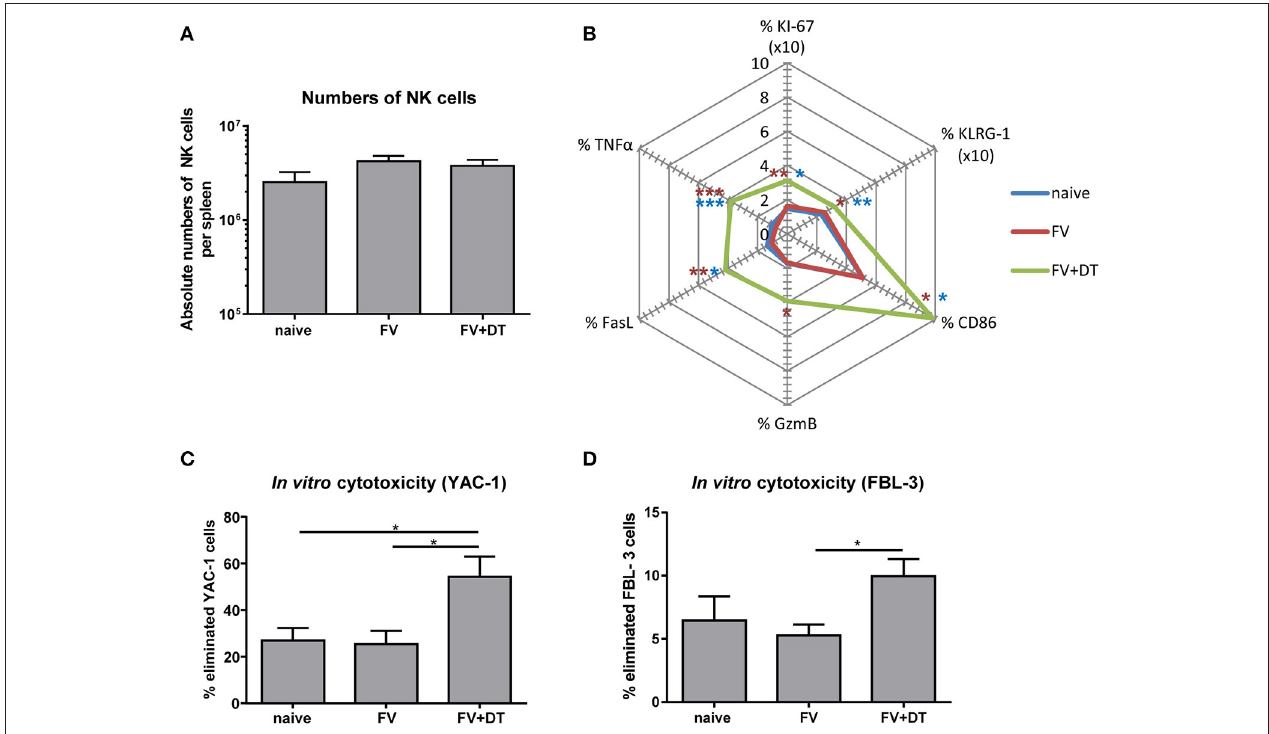
FIGURE 1 | Influence of Tregs on the NK cell phenotype during an acute FV infection. C57BL/6 and DEREG mice were infected with FV and Tregs were depleted by application of diphtheria toxin (DT) into DEREG mice. Splenocytes were harvested at 3 dpi and naïve mice were used as controls. Absolute numbers of splenic NK cells were analyzed by flow cytometry by gating on viable CD3 − NK1.1 + CD49b + cells (A) . Mean values of cell numbers from at least 11 animals are shown, with standard errors of the means (SEM) indicated by error bars (naïve n = 11, FV n = 16, FV + DT n = 16). Effector functions of NK cells were analyzed by KI-67, KLRG-1, CD86, GzmB, FasL, and TNF α and mean percentages are shown in a spider plot (B) . At least 8 animals per group from at least three independent experiments were used for the analysis (KI-67, KLRG-1, CD86, GzmB: naïve n = 11, FV n = 16, FV + DT n = 16; FasL, TNF α : naïve n = 9, FV n = 16, FV + DT n = 10). Statistically significant differences were analyzed by Kruskal–Wallis test (KI-67, CD86, GzmB, and FasL) or Ordinary one-way ANOVA (KLRG-1 and TNF α ). Differences between groups of naïve mice and Treg-depleted mice (FV + DT) were indicated by blue asterisks whereas differences between the groups of FV-infected animals (FV) compared to groups of Treg-depleted mice (FV + DT) were indicated by red asterisks. The cytotoxicity of NK cells was analyzed by co-incubation of isolated NK cells with CFSE-labeled YAC-1 cells ( C ; naïve n = 11, FV n = 11, FV + DT n = 6) or FV-induced FBL-3 cells ( D ; naïve n = 7, FV n = 11, FV + DT n = 7). After co-incubation, cells were stained for viability and immediately analyzed by flow cytometry. At least 6 animals per group from at least three independent experiments were used for the analysis. Statistically significant differences were analyzed by Kruskal–Wallis test are indicated as follows: * p < 0.05, ** p < 0.01, *** p <